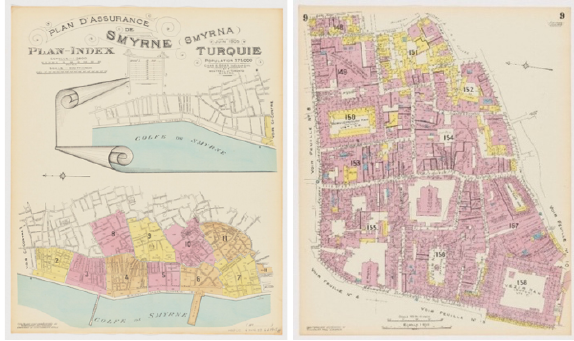
Figure - 4. Master map of Charles E. Goad fire insurance